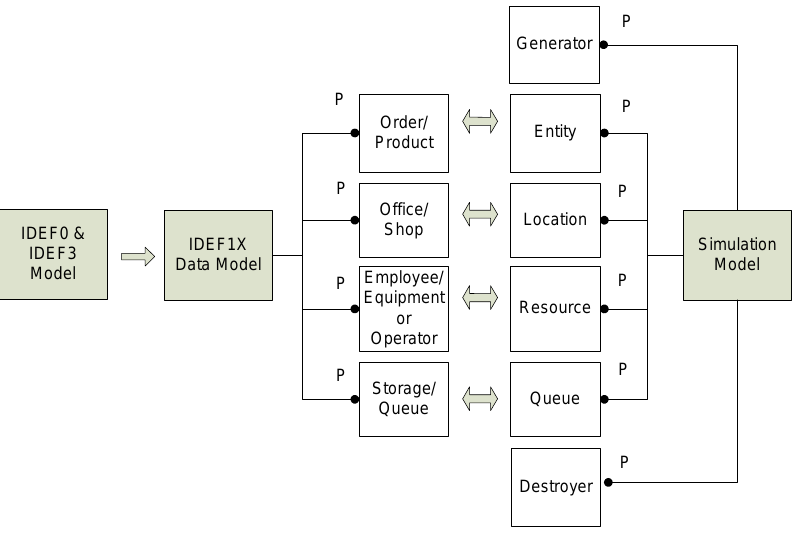
Figure 5. “Simulation and data model